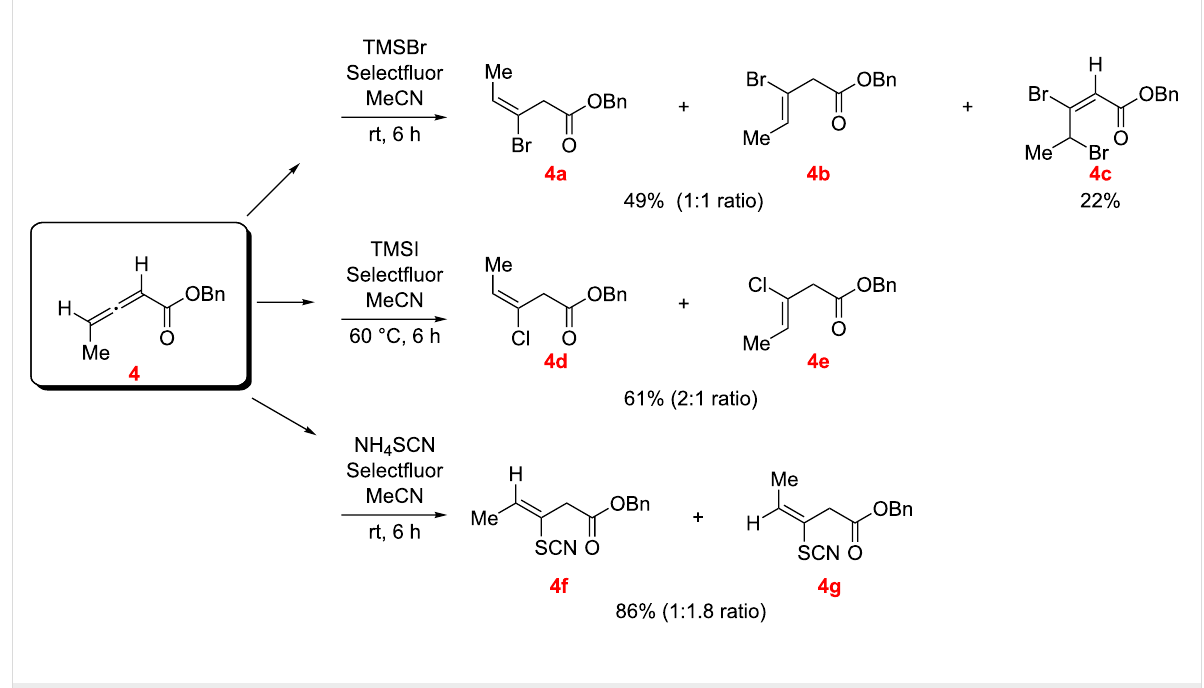
Scheme 7: Reaction of benzyl allenoate 4 with TMSX (X = Br, and Cl)/Selectfluor and NH 4 SCN/Selectfluor ( E/Z designations, as illustrated, were made by NMR; see Supporting Information File 1).